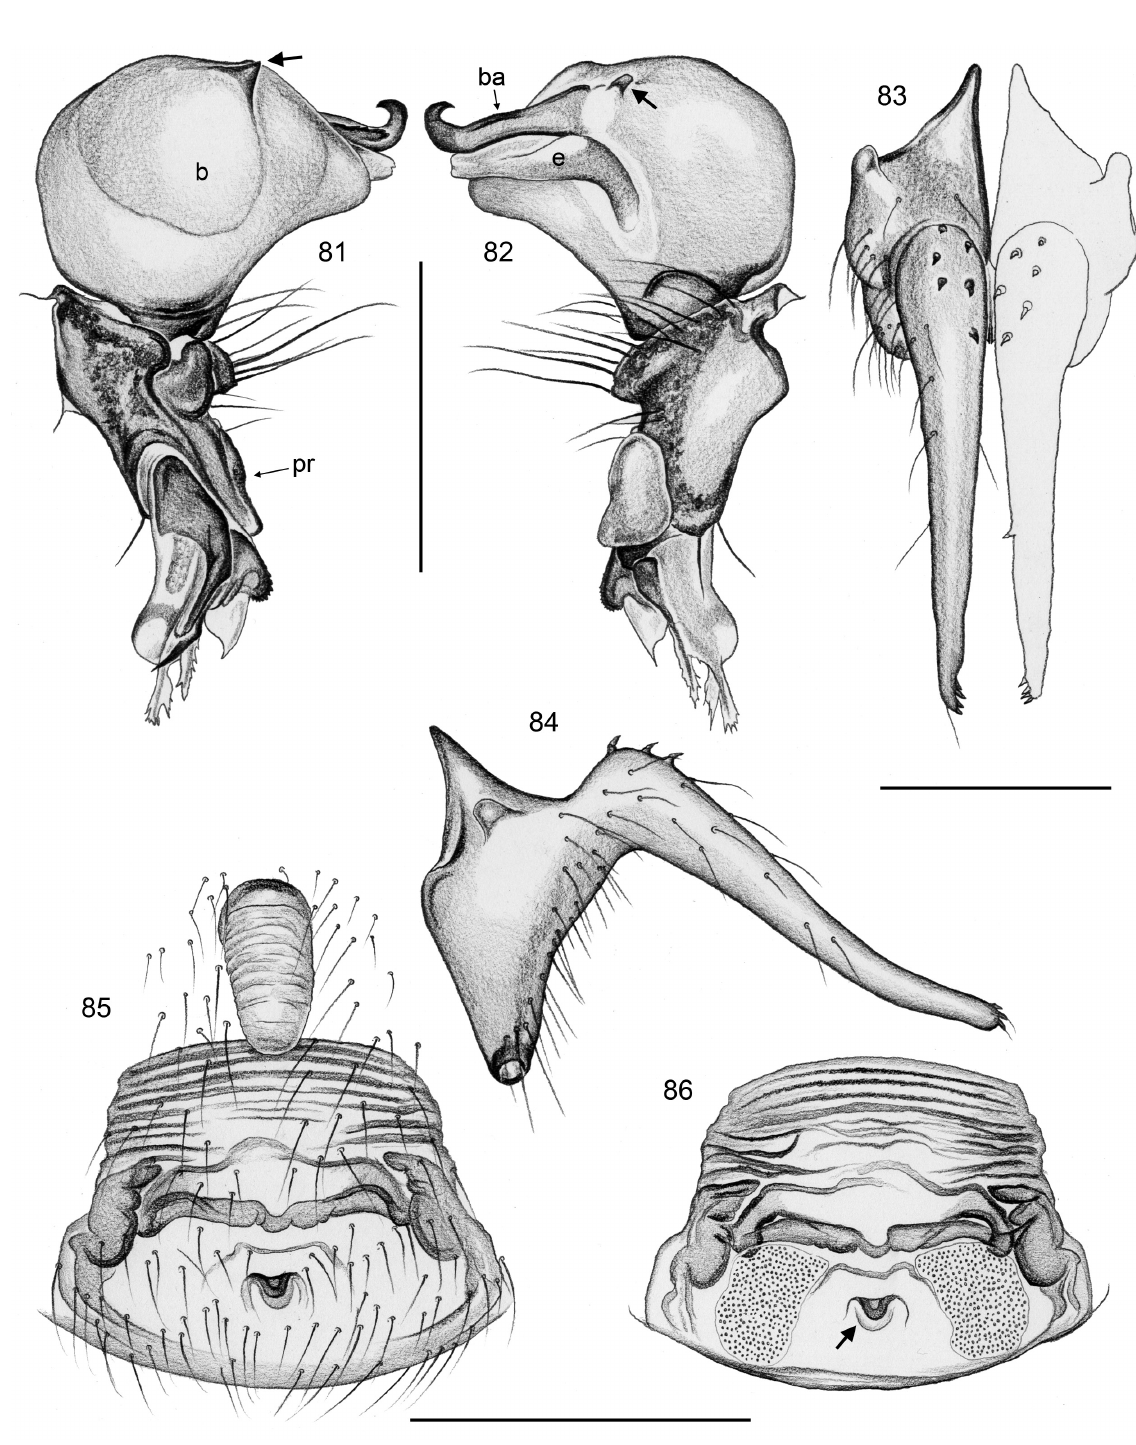
Figs 81-86. Buitinga batwa sp. nov. 81-82. Left ♂ procursus and bulb, prolateral and retrolateral views. 83-84. ♂ chelicerae, fronto-dorsal and lateral views. 85-86. ♀ genitalia, ventral and cleared dorsal views (arrow points at distinctive internal pocket). b: genital bulb; ba: bulbal apophysis; e: embolus; pr: procursus. Scale lines: 0.3 mm (83-84), 0.5 mm (81-82,